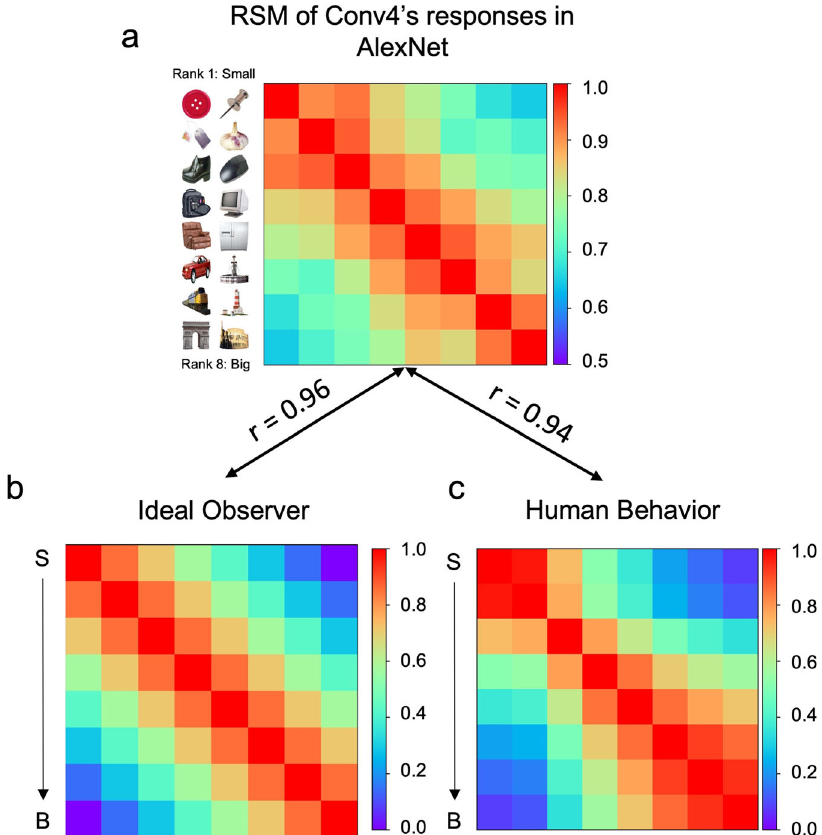
Fig. 1 Representation of objects ’ real-world size emerged in AlexNet designated for object recognition. a The RSM of units ’ responses at Conv4 layer to objects with different sizes, and objects with similar sizes elicited similar response patterns indexed by warm colors. b The RSM of the ideal observer and c human showed high correspondence to that of AlexNet. S small objects, B big